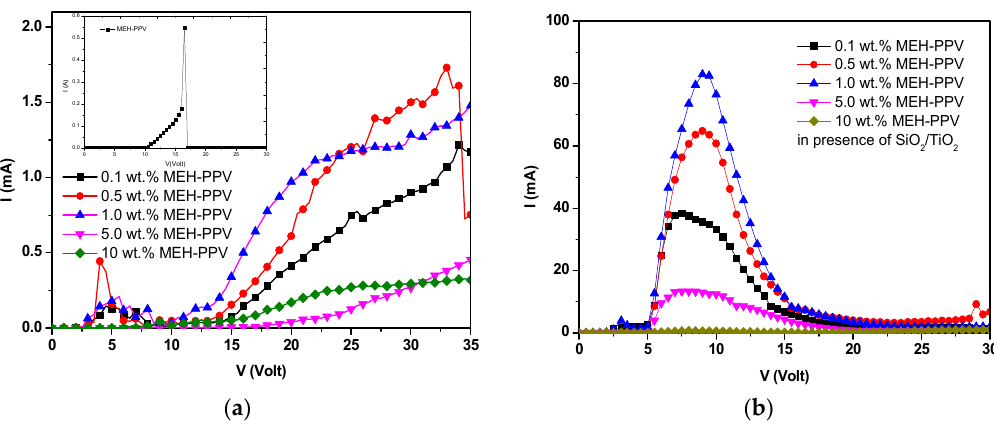
Figure 1. Current-voltage (I-V) measurements of the OLEDs based on hybrids of PFO/MEH-PPV. ( a ) In the absence of SiO 2 /TiO 2 nanocomposites; ( b ) in the presence of SiO 2 /TiO 2 nanocomposites. The inset shows the I-V curve of the OLEDs based on pristine MEH-PPV.